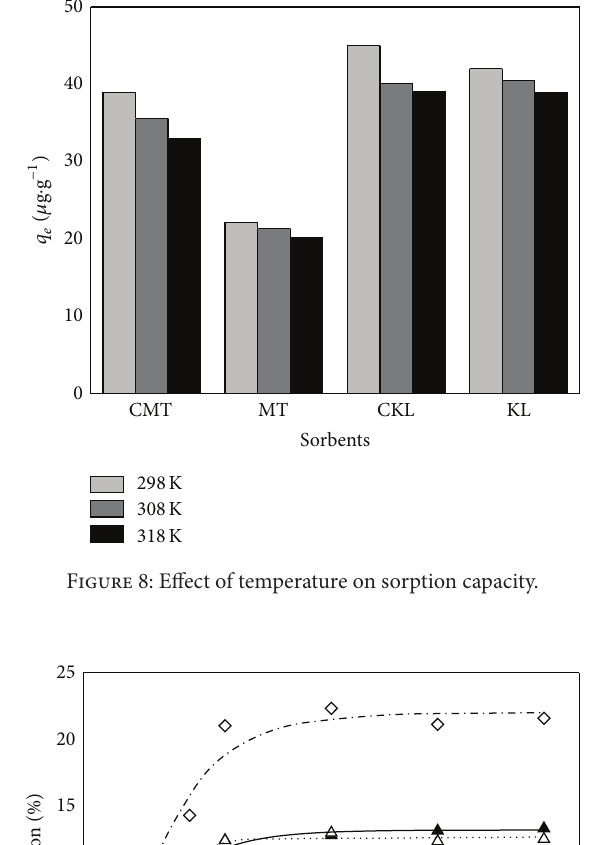
Figure 8: Effect of temperature on sorption capacity.